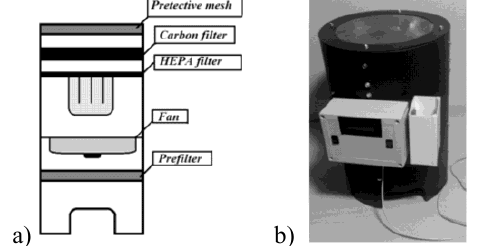
Fig. 1. Diagram of arrangement of elements inside the filter (a) and photo of the model